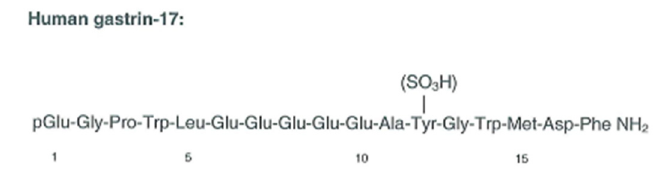
Figure 1. The structure of gastrin-17, the first identified molecular form of gastrin in antral G cells